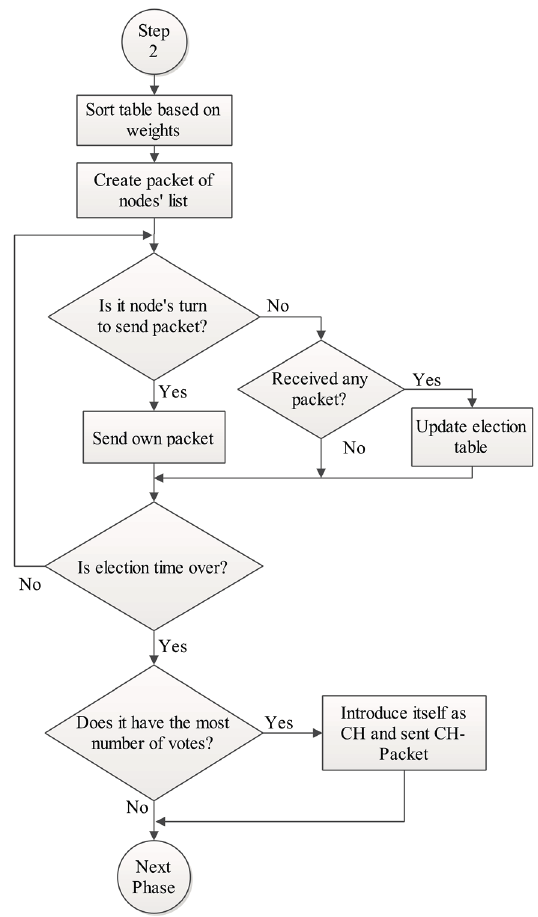
Figure 6. Phase B: Cluster head election phase, Step